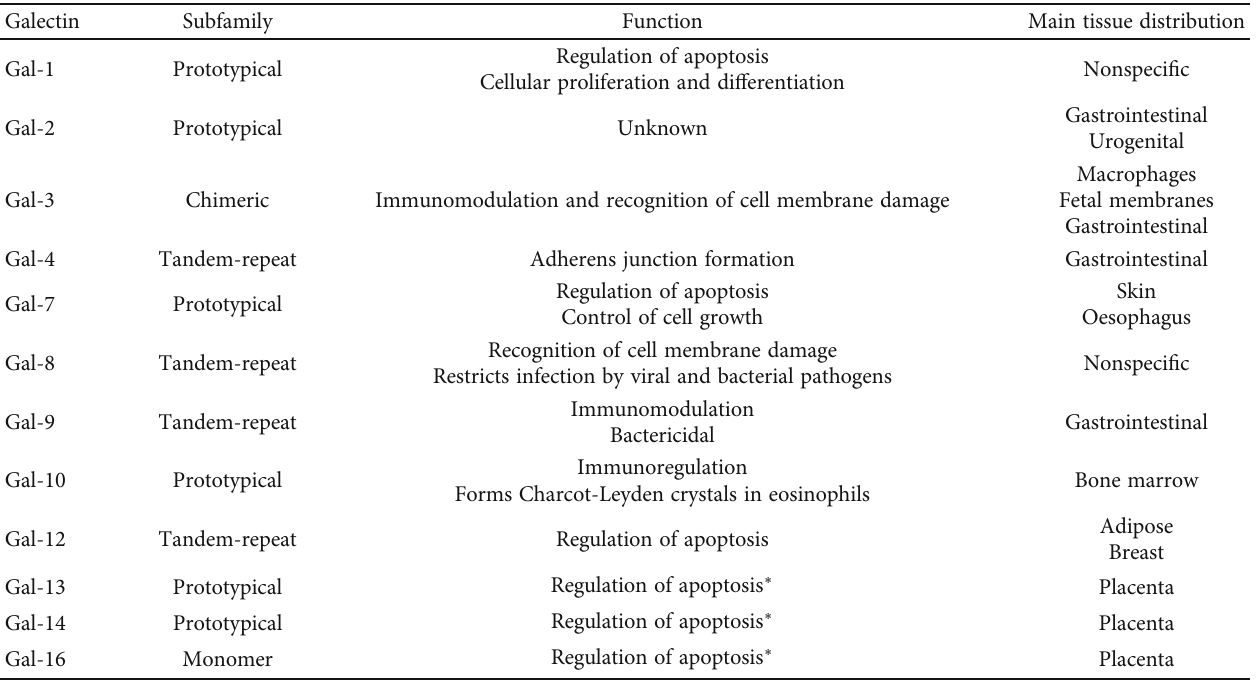
Table 1: Structure and function of galectins found in humans [14,